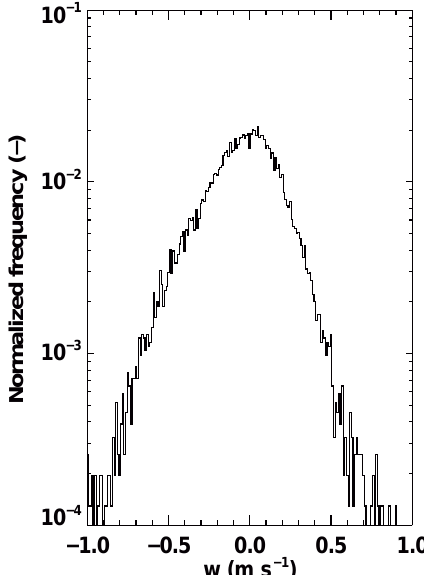
Figure 16. Vertical wind speeds retrieved from 19:06UTC on 1 April to 02:23UTC on 2 April at elevations of 6.1–12.0km, from a sample size of 123469 retrievals obtained in 47 layers at 10s res-